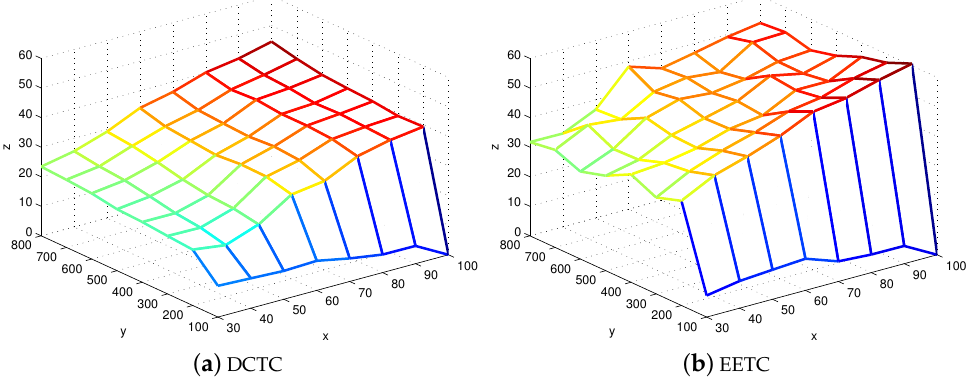
Figure 14. The average number of active sensor nodes in connected cover sets.